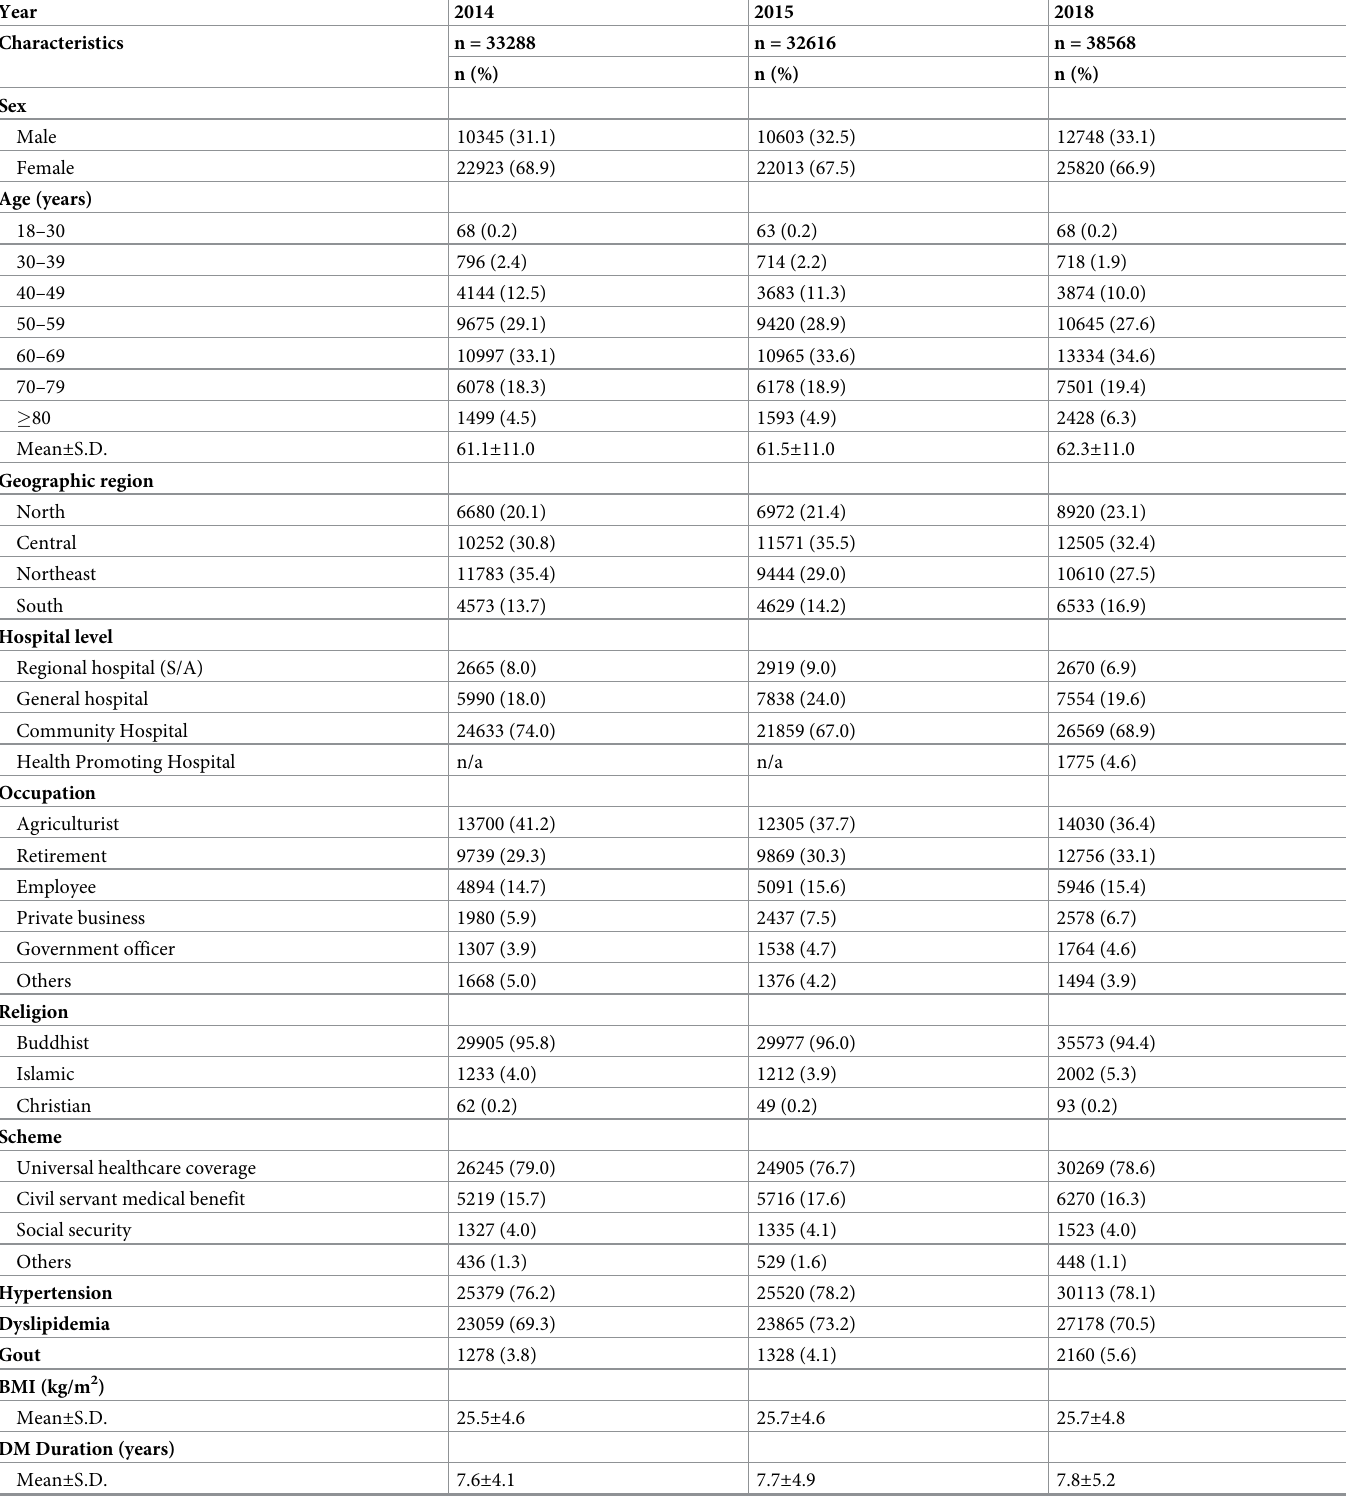
Table 1. Demographic characteristics of participants (n =